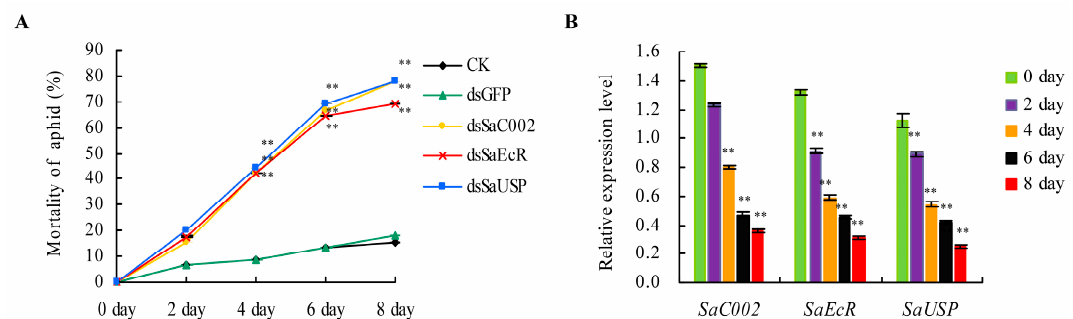
Figure 3. Mortalities and the relative expression levels of SaEcR and SaUSP of grain aphid at different time points upon feeding on artificial diet added with dsRNAs. ( A ) The mortality of the second instars of grain aphid fed on artificial diet added with dsRNA. CK, represents the blank artificial diet control without dsRNA. dsGFP represents the artificial diet with added dsRNA of GFP as a negative control; dsC002 represents the artificial diet with added dsRNA of C002 as a positive control. The dsRNAs were added to the artificial diet at a concentration of 7.5 ng/ μ L. The survival of the nymphs was monitored over an eight day period. Values and error bars reflect the mean and SEM of six independent biological replicates, each with a pool of 30 individual aphids (Student’s t -test, n = 6, ** p < 0.01); ( B ) The relative expression levels of SaC002 , SaEcR , and SaUSP genes upon feeding on artificial diet containing dsRNA at different time points. Quantitative real-time PCRs (qRT-PCRs) were performed using the total RNA from the survived instars at different time points after feeding on artificial diet containing the respective dsRNAs. The relative expression levels of target genes were monitored at indicated time points over an eight day period. The expression levels of both genes were knocked-down significantly after dsRNA feeding at day 4 and thereafter. Values and error bars represent the mean and SEM of three independent biological replicates, each with a pool of eight surviving individual aphids (Student’s t -test, n = 3, ** p < 0.01).